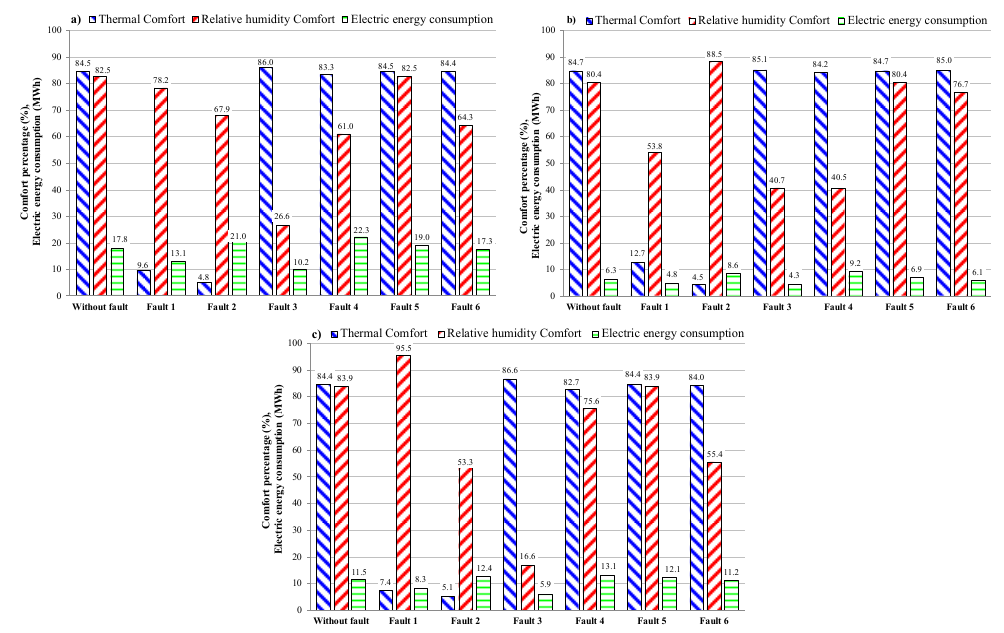
Figure 14. Comfort hours and electric consumption with/without faults: whole year ( a ), heating period ( b ), cooling period ( c ).